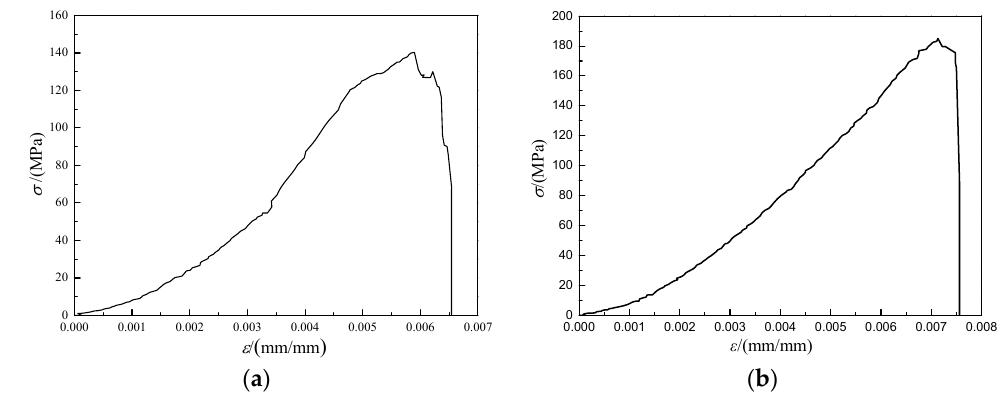
Figure 8. The test result of elastic modulus: ( a ) NR; ( b ) ATWR.